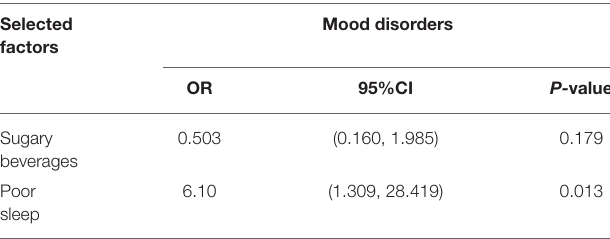
TABLE 7 | Multivariate logistic regression analyses on selected factors associated with FD and mood disorders. Selected